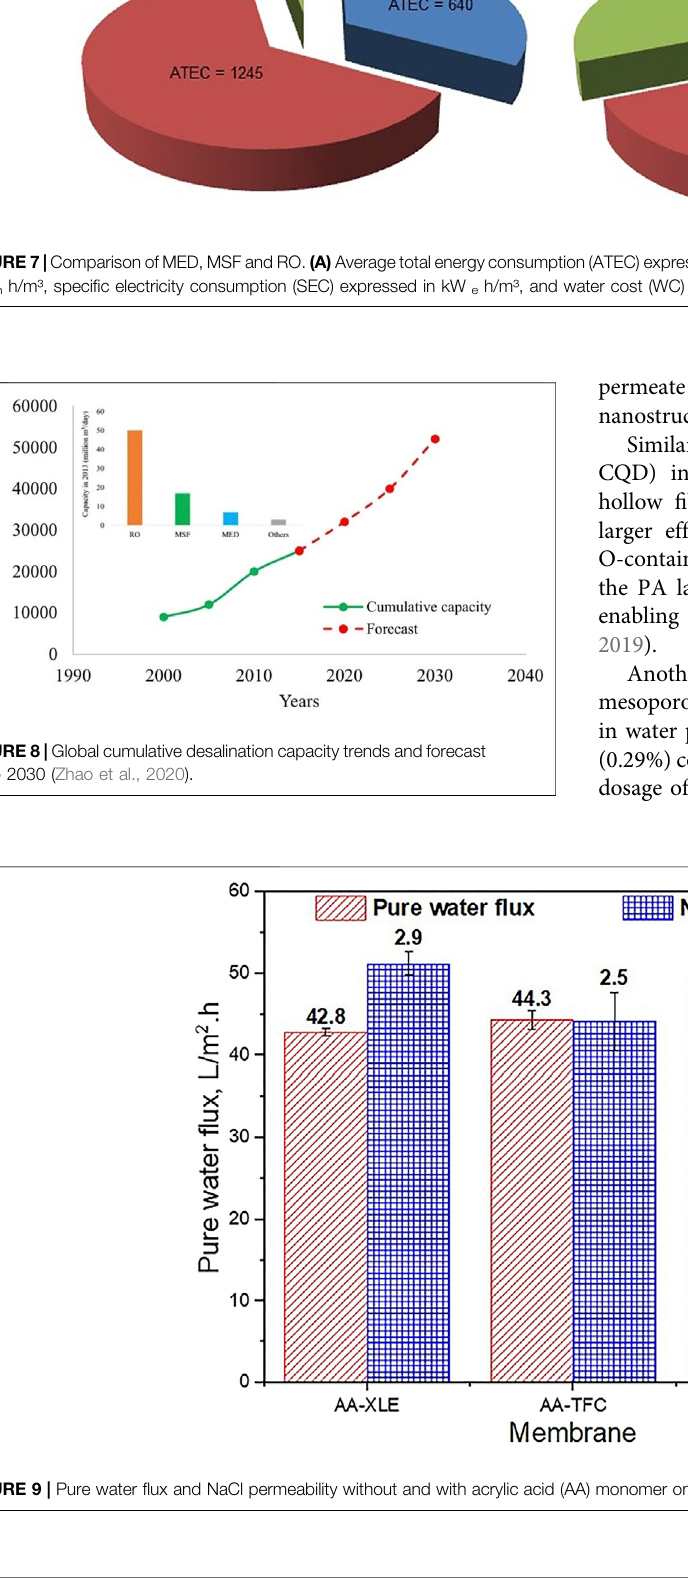
Frontiers in Chemistry |